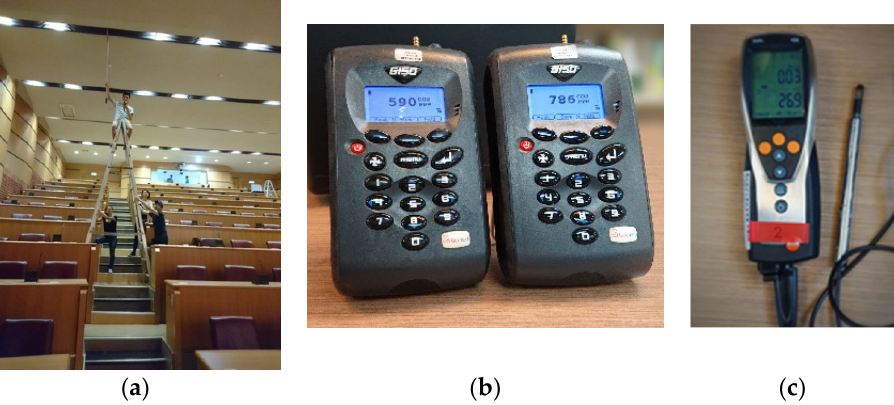
Figure 2. Actual measurement in the field: ( a ) Air velocity measurement in the inlet; ( b ) Geotech G150 CO 2 sensor; ( c ) Anemometer TESTO 435-2.